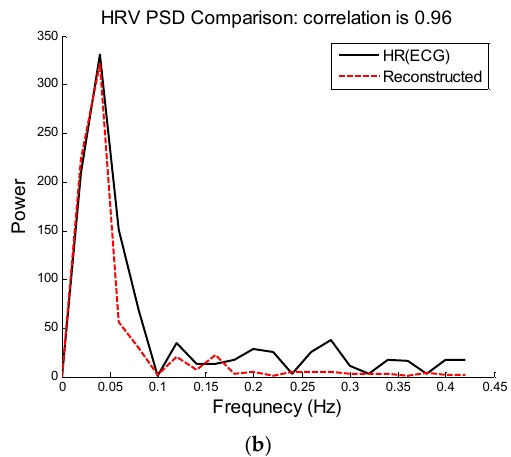
Figure 10. Subject 30 (Chon Lab Dataset). ( a ) Reconstructed HR vs. reference HR. ( b ) Spectral comparison of reconstructed HR and reference HR (estimated from reference ECG).